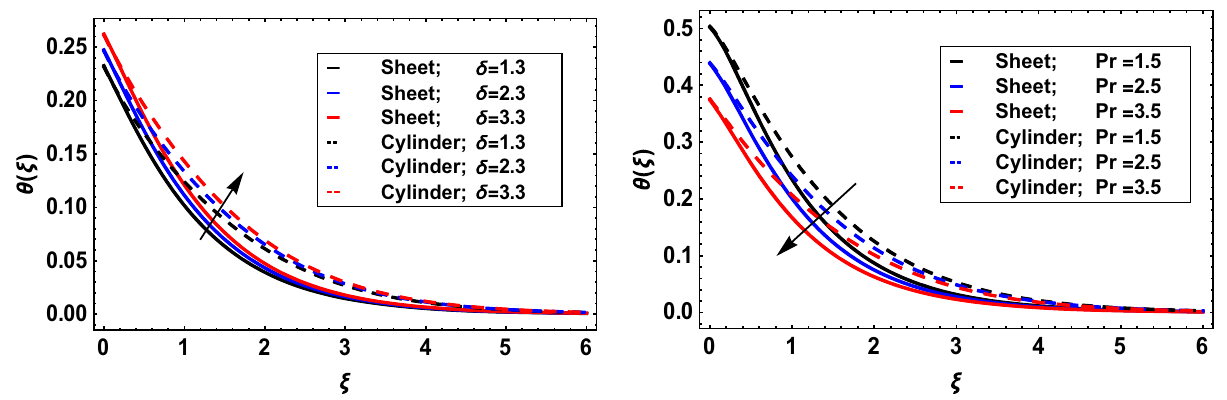
Figure 8: Change in nano fl uid temperature due to δ . Figure 10: Change in nano fl uid temperature due to Pr .